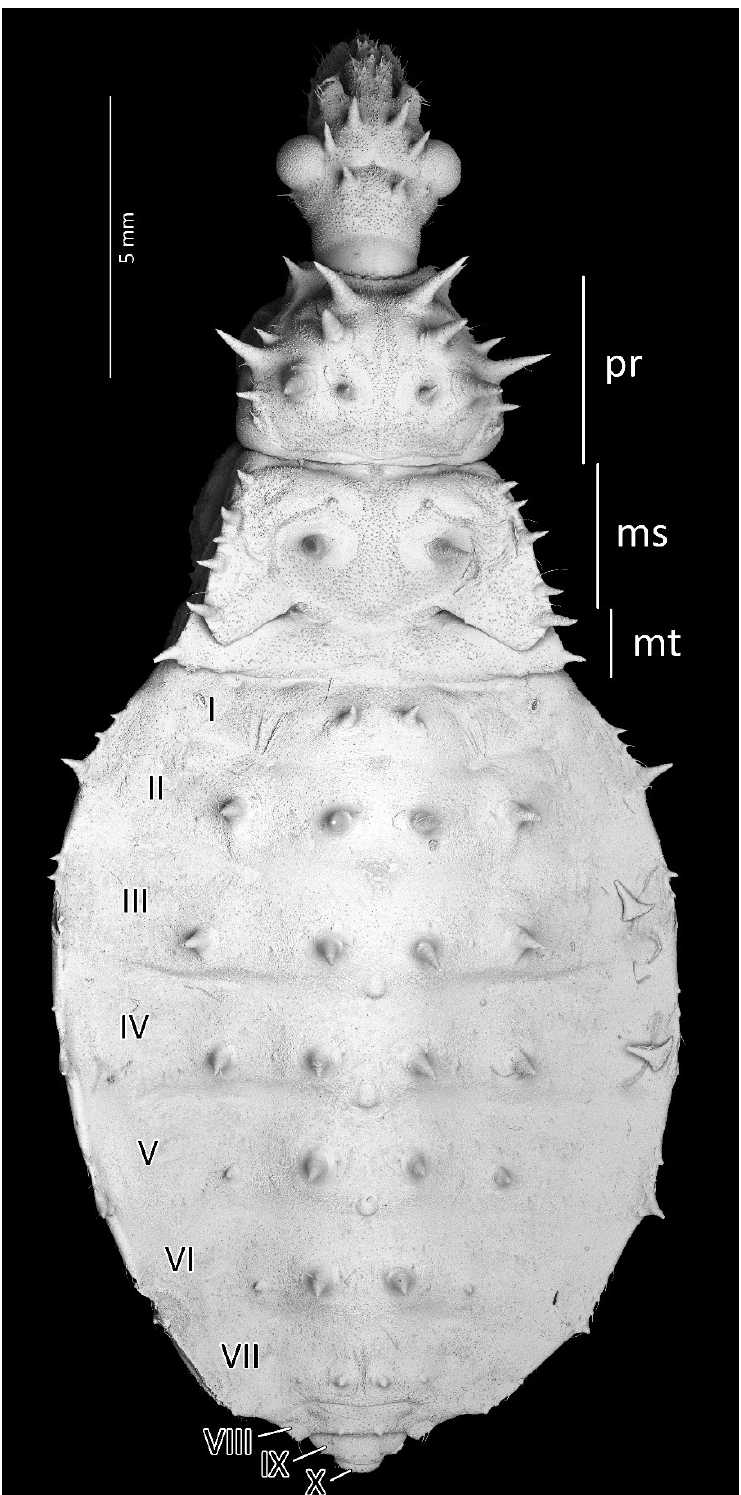
Figure 12. Dorsal habitus of the fourth instar of Psyttala horrida (Stål, 1865), detailed SEM view. ms —mesonotum; mt —metanotum; pr —pronotum; I – X —abdominal segments. Fifth Instar Colouration: Head and thorax black, except pale middle part of tergite of metathorax, ventral side of mesothorax (mesotergite with pale longitudinal ridge). Scape and pedicel black. Basi- and distiflagellomere dark brown. All antennomeres covered with brown and